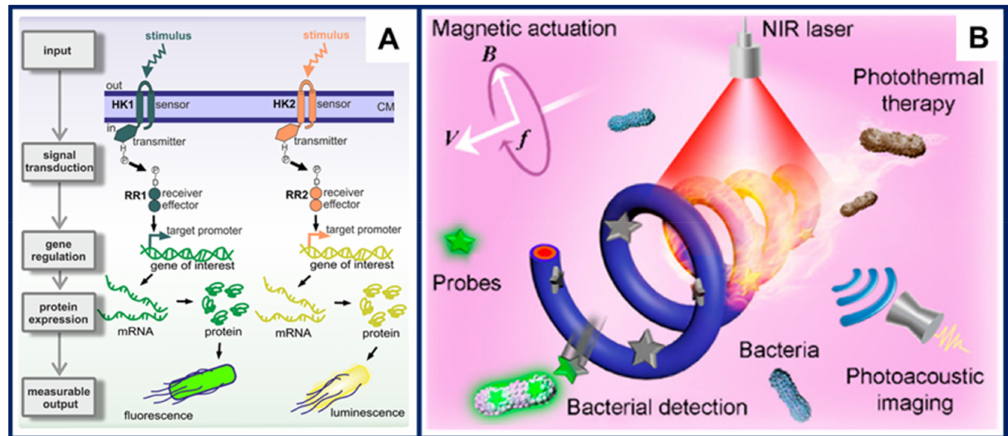
Figure 7. Recent examples of microswimmers with sensing capabilities. ( A ) Signal transduction pathway engineered into biohybrid microswimmers based on Bacillus subtilis . The presence of certain stimuli in the microswimmer environment ultimately leads to a measurable output, either